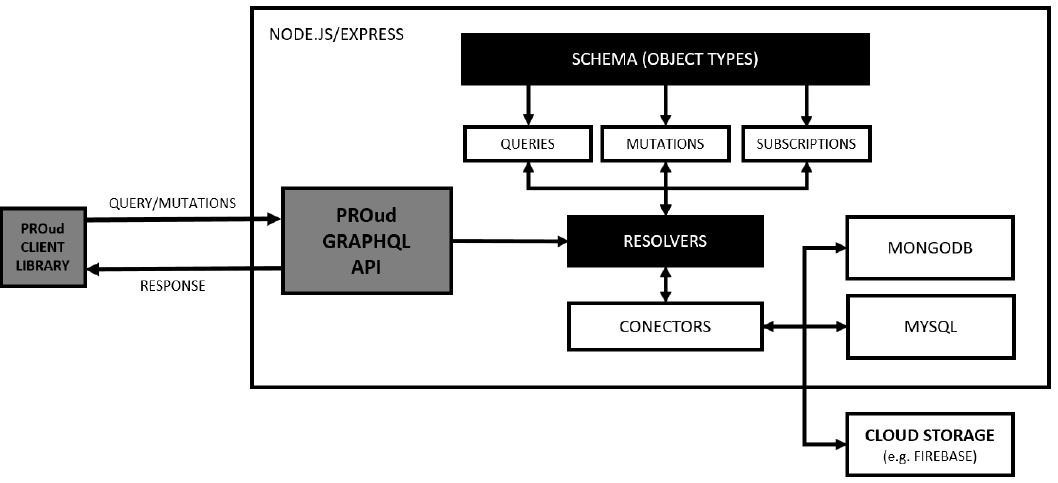
Figure 4. PROud server